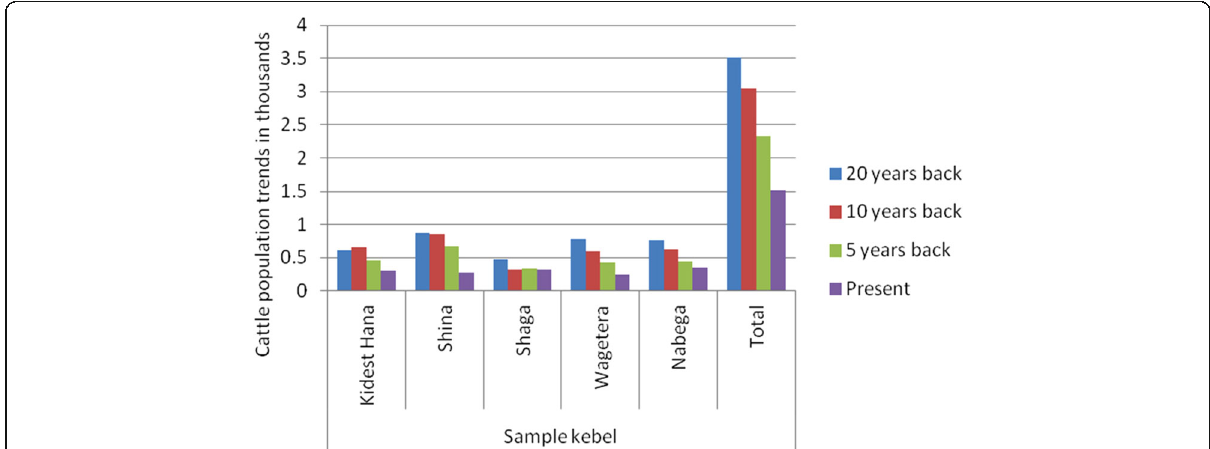
Fig. 3 Mean cattle number per household summed over five kebeles in the Fogera